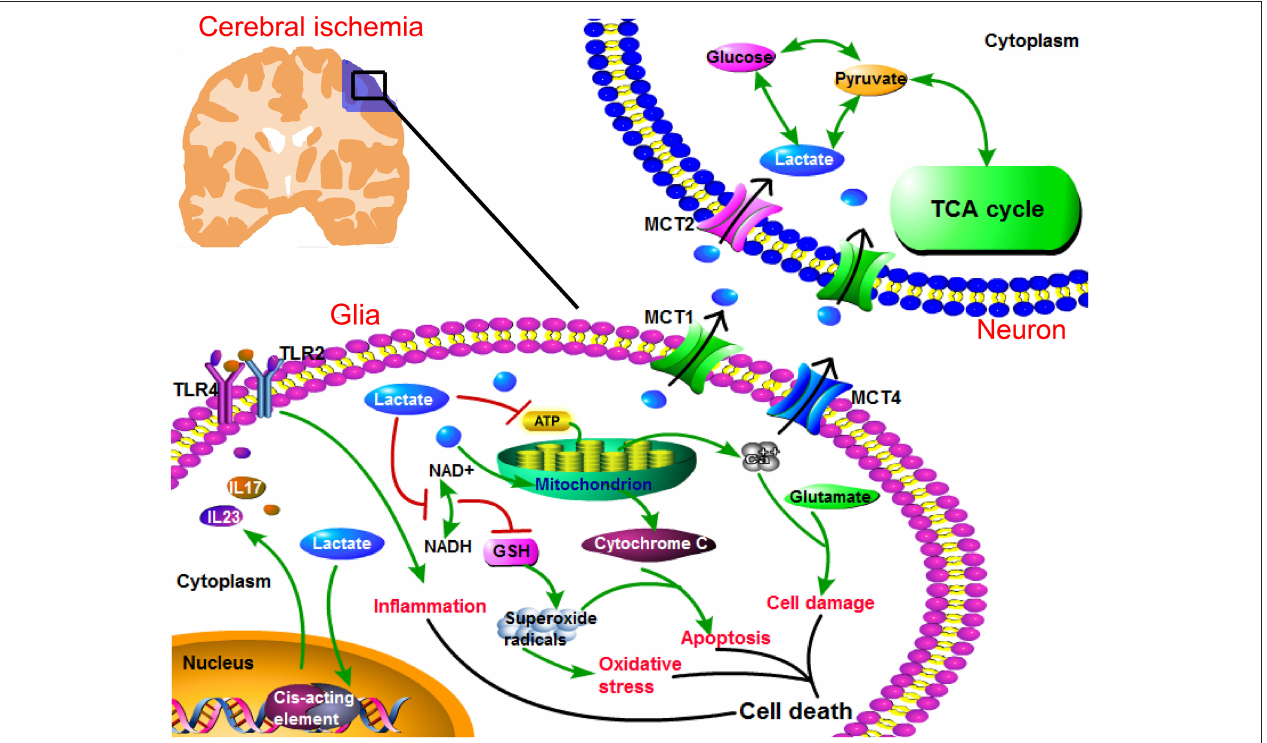
FIGURE 3 | Regulation of MCT1 in lactate transport promotes neuronal energy supplement, and suppresses cellular damage under ischemic attack. In ischemic brain, anaerobic glycolysis is largely enhanced and leads to lactate overproduction. Lactate becomes the main energy resource for neurons, while its intracellular accumulation (in glial cells) leads to toxic response. Specifically, lactate accumulation associates with cellular responses, such as inflammation, oxidative stress, apoptosis, Ca 2 + overload, and glutamate-induced excitotoxicity. Especially, lactate can promote the transcription of proinflammatory factors (interleukin 23/interleukin 17 (IL23/IL17)), which triggers inflammation via toll-like receptor 2/toll-like receptor 4 (TLR2/TLR4). In addition, lactate can suppress the production of glutathione (GSH) which is an indispensable anti-oxidative enzyme, and GSH deficit leads to the increased superoxide radicals. Then, superoxide radicals can further activate oxidative stress. Again, superoxide radicals contribute to apoptosis in the presence of mitochondrial cytochrome C. Furthermore, lactate decreases adenosine triphosphate (ATP) level, resulting in Ca 2 + overload. Ca 2 + overload coexists with glutamate-induced excitotoxicity which leads to cellular damage. Collectively, intracellular lactate accumulation contributes to these cellular responses, leading to cell death. Therefore, a timely and rightly utilization of lactate protects brain from I/R injury. MCT1 can facilitate lactate efflux from glial cells, and assist lactate influx into neurons. Besides, neuronal MCT2 assists lactate entries into neurons, and then lactate is efficiently utilized by